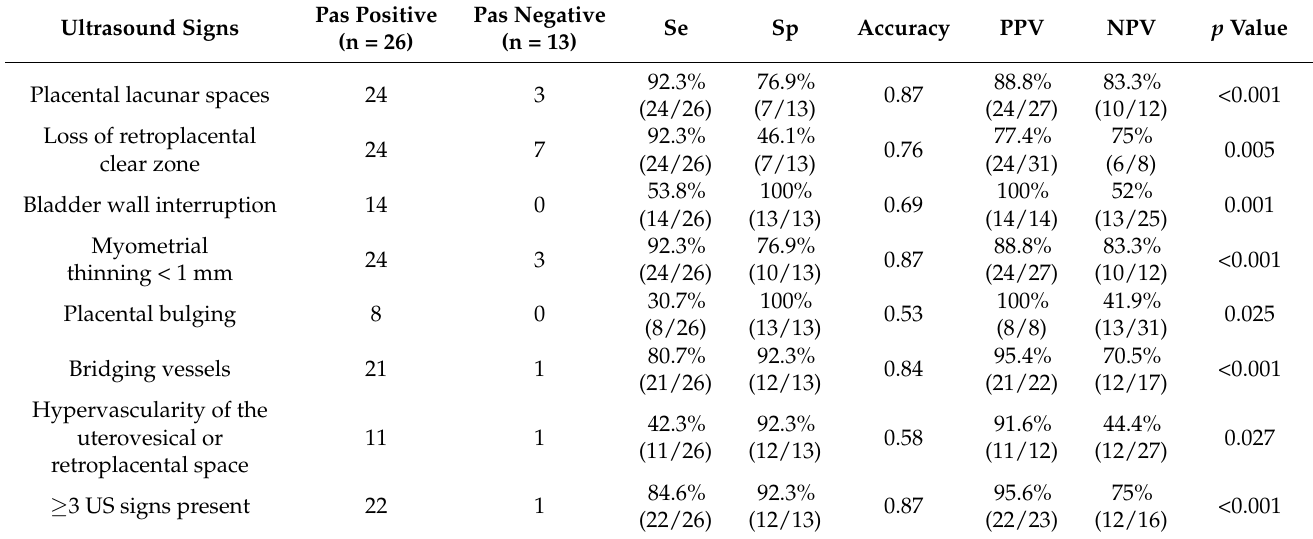
Table legend: Se—sensibility; Sp—specificity; PPV—positive predictive value; NPV—negative predictive value. The results from the multivariate analysis of ultrasound signs indicated a significant association between placental lacunar spaces, myometrial thinning, and grade I and II PAS ( p = <0.001 and p = 0.024); between the loss of retroplacental clear zone, grade I PAS ( p = 0.005), and grade II PAS ( p = 0.047); between bladder wall interruption, grade IIIa PAS